Question: What style of plot is this figure drawn as?
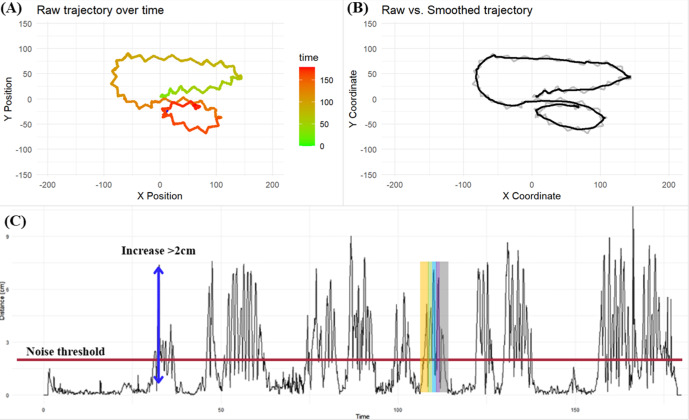
Answer: line